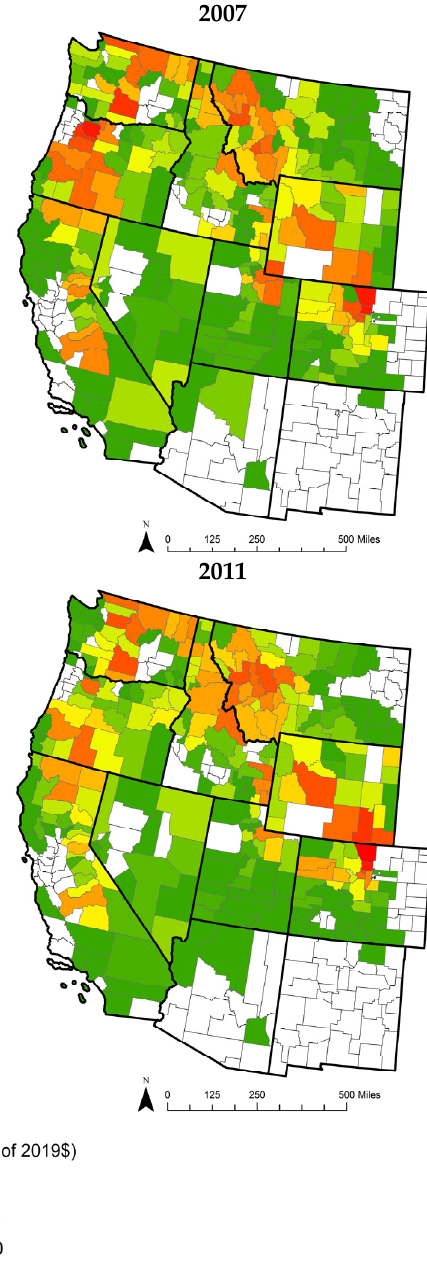
Figure 2. PM 2.5 mortality health costs (millions of 2019 USD) due to MPB tree deaths in the Western US for 2005, 2007, 2009, and 2011. Areas in white had no measurable MPB tree deaths in the year